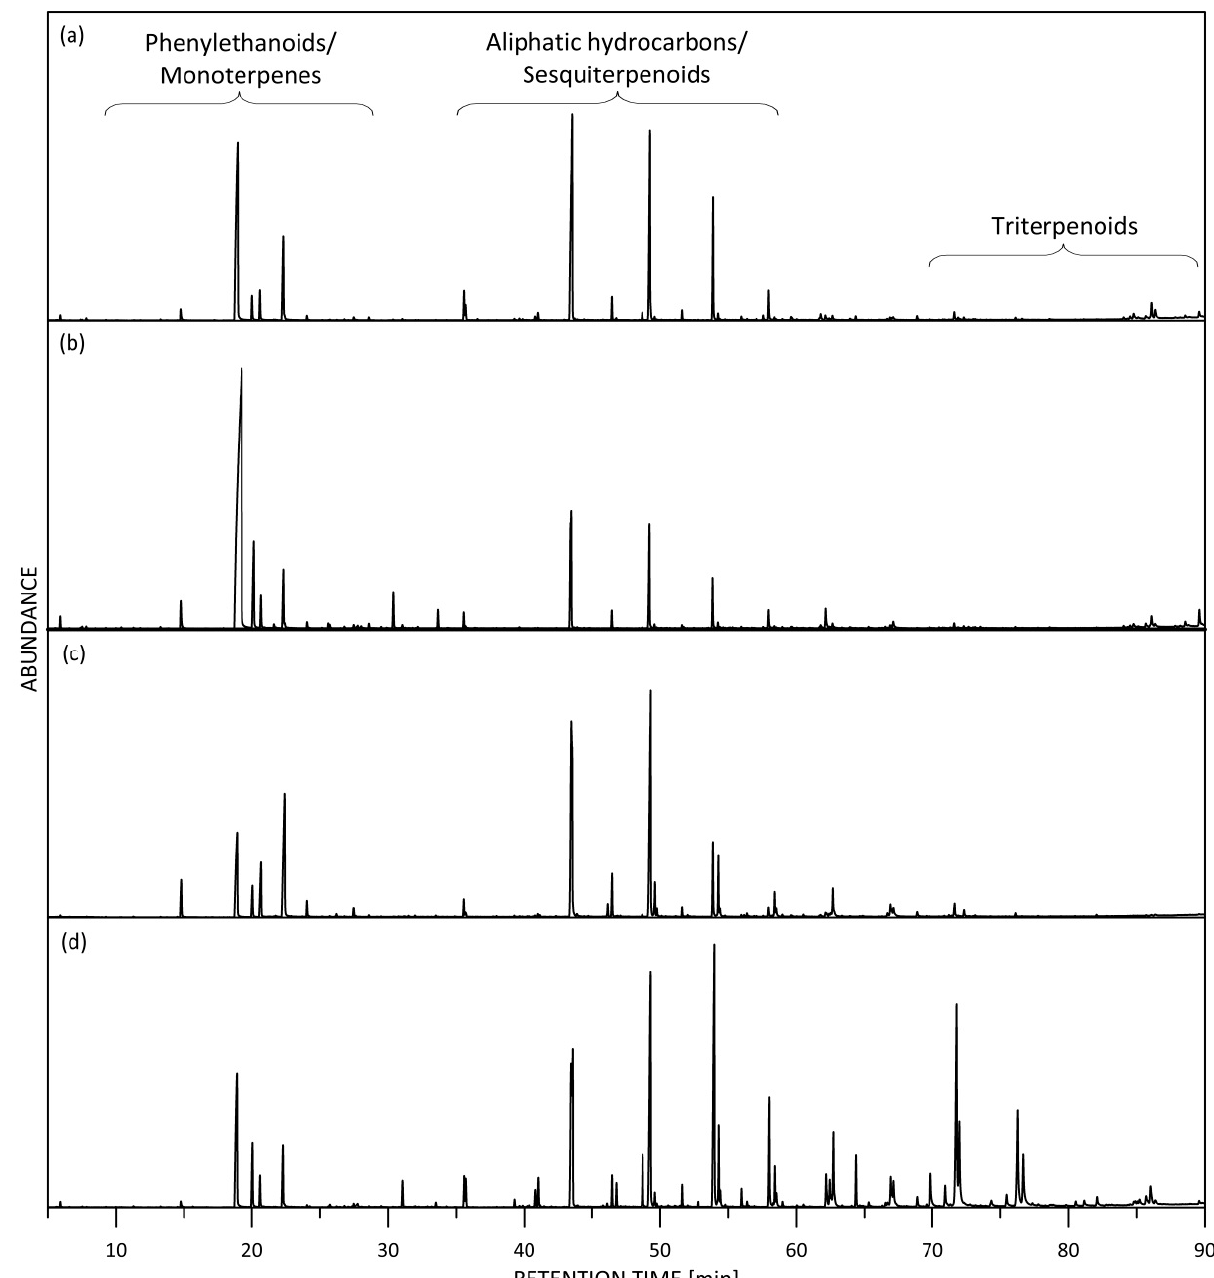
Figure 1. GC/MS profile of subcritical (1,1,1,2-tetrafluorethane) extracts on a DB-17HT column: ( a ) R. gallica ; ( b ) R. damascena ; ( c ) R. alba ; ( d ) R. centifolia. Table 1. Chemical composition of R134a rose extracts, as determined using GC/MS/FID on a DB-17HT column.